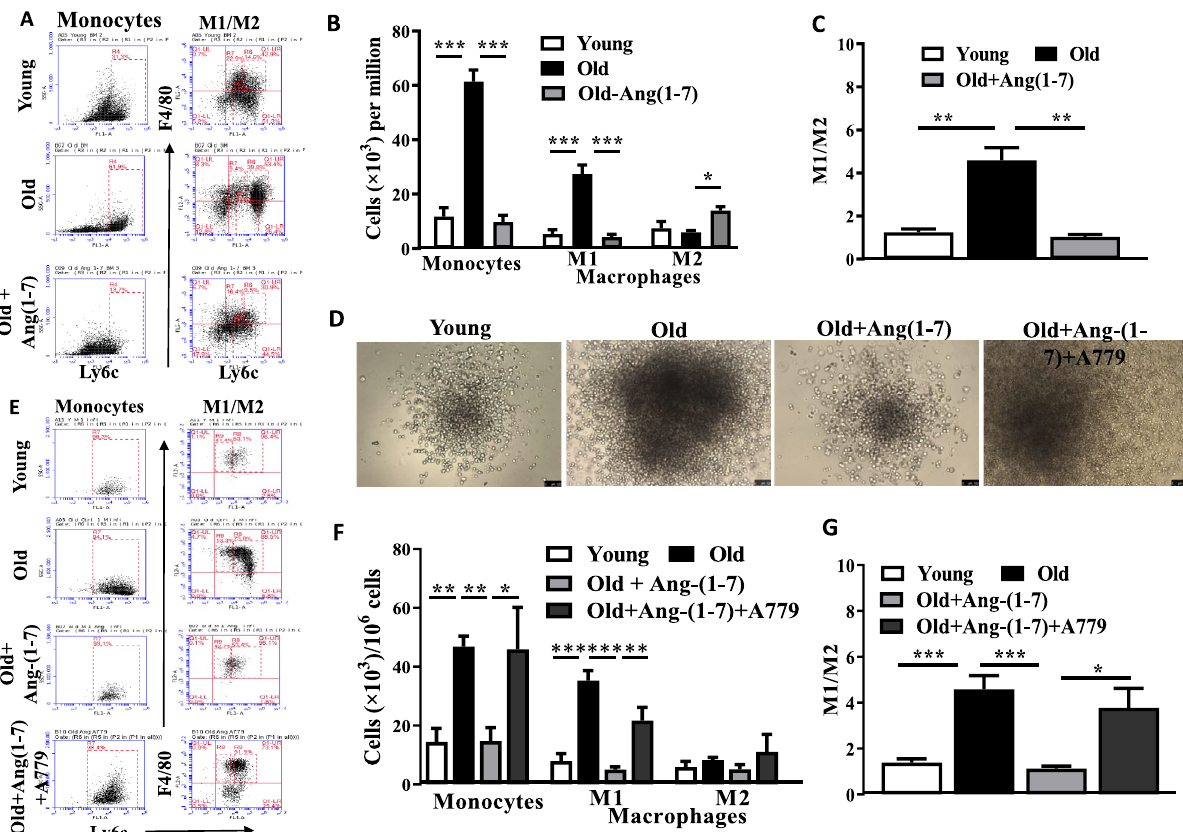
Figure 2. Myelopoiesis is increased in aging and reversed by Ang-(1–7): ( A ) Representative flow-cytometry dot plots for enumeration of monocyte-macrophages in the bone marrow derived from Young, Old or Old mice treated with Ang-(1–7). ( B ) Monocytes (Ly6G - CD11b + Ly6C + cells) were significantly higher in the Old bone marrow compared to the Young (P < 0.001, n = 6) and decreased by Ang-(1–7) to the similar levels as Young (P < 0.001). M1 macrophages (Ly6G - CD11b + Ly6C high F4/80 + ) were higher in the Old bone marrow (P < 0.001) that was reversed by Ang-(1–7) (P < 0.001, n = 6). M2 macrophages (Ly6G - CD11b + Ly6C low F4/80 + ) in Old bone marrow were similar to that observed in the Young but significantly increased by Ang-(1–7) (P < 0.05, n = 6). ( C ) M1/M2 ratio was higher in the Old bone marrow (P < 0.01, n = 6) that was decreased by Ang-(1–7) (P < 0.01, n = 6). ( D ) Representative bright field images of CFUs derived from bone marrow cells of Young, Old or Old treated with Ang-(1–7) or Ang-(1–7) and A779. ( F ) Higher number of monocytes (P < 0.01, n = 6) and M1 macrophages (P < 0.001, n = 6) were generated in the CFU assay by Old bone marrow cells compared to the Young, that were decreased by Ang-(1–7) (P < 0.01 and P < 0.001 for monocytes and M1 macrophages, respectively, n = 6). Concurrent administration of A779 reversed the effect of Ang-(1–7) (P < 0.01 vs Ang-(1–7)- treated group). M2 macrophages were similar in all groups. ( G ) M1/M2 ratio is higher in CFUs generated by Old bone marrow cells (P < 0.001, n = 6) that was decreased by Ang-(1–7) (P < 0.001, n = 6). This effect was not observed with the simultaneous administration of A779 (P < 0.05 vs Ang-(1–7)-treated group). All groups were tested by One-way ANOVA with Tukey’s post-test for multiple comparisons. Scale bar measures 100 positive cells in the areas of injury were higher in the Old group compared to the Young, which were decreased by Ang-(1–7) treatment (P < 0.001, n = 6) (Fig. 3C–F). In agreement with our previous study 39 , blood flow was progressively recovered following HLI in the Young mice with the maximum blood flow of 88 ± 4% compared to that found in the nonischemic contralateral limb by day-28 following ischemic injury. Maximum blood flow recovery in the Old group at day-28 post-HLI was lower compared to the Young (51 ± 7%, P < 0.001, n = 6) (Fig. 4A,B). In the group of Old saline-treated mice, either toe or foot amputations were observed. Blood flow recovery was increased by treatment with Ang-(1–7) to 84 ± 5% (n = 6) with no evidence for amputations (Fig. 4A,B). In line with blood flow recovery, H&E staining revealed presence of necrotic areas in the gastrocnemius muscle derived from Old mice compared to the Young (Fig. 4C), while muscle sections derived from Ang-(1–7)-treated Old mice showed no signs of necrosis (n = 6, Fig. 4C). Along similar lines, the capillary density as measured by CD31 or IlB4 positivity, was lower in the Old group compared to the Young in the ischemic regions of gastrocnemius muscle (P < 0.05, n = 6), which was significantly increased by Ang-(1–7) treatment (P < 0.05, n = 6) (Fig. 4C–E). Then, the study focused on characterizing molecular signatures of increased myelopoiesis in Old BM hemat- opoietic progenitor-enriched cells. Gene expression, of pro-myelopoietic and pro-inflammatory factors, and